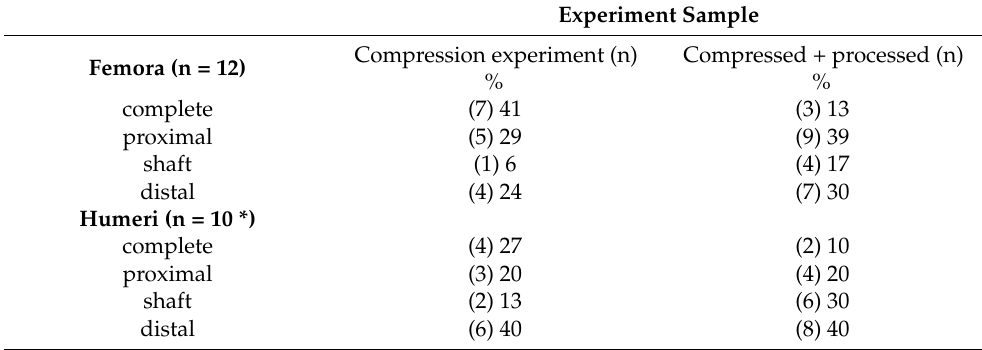
Table 5. Frequency of long bones (femora and humeri) obtained following compression on current specimens. Several long bones bear cracks or fissures that may result in detachment of parts during sample processing, conforming to what we have called the “compressed + processed sample”. * two out of the eight humeri showed a very different response in each compression attempt, and they have been accounted for as two different results given the strong differences observed in the third step of compression, resulting n =